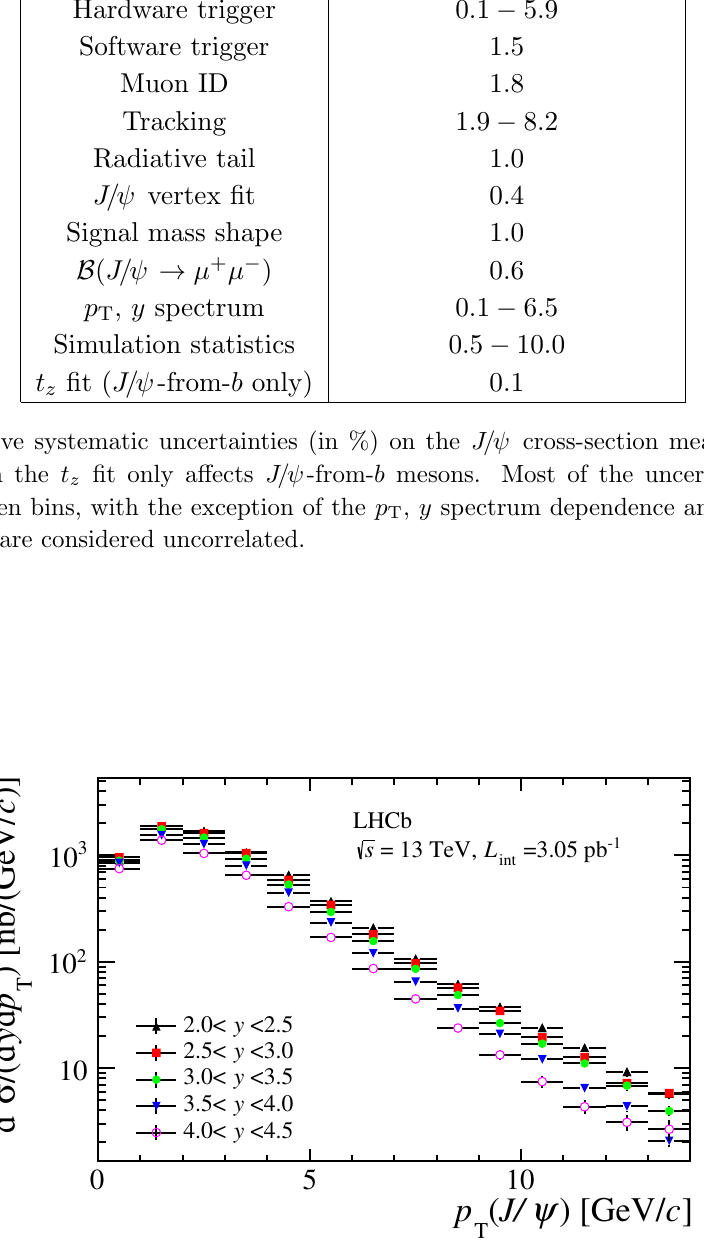
Figure 2 . Double di(cid:11)erential cross-section for prompt J= mesons as a function of p T in bins of y . Statistical and systematic uncertainties are added in quadrature.